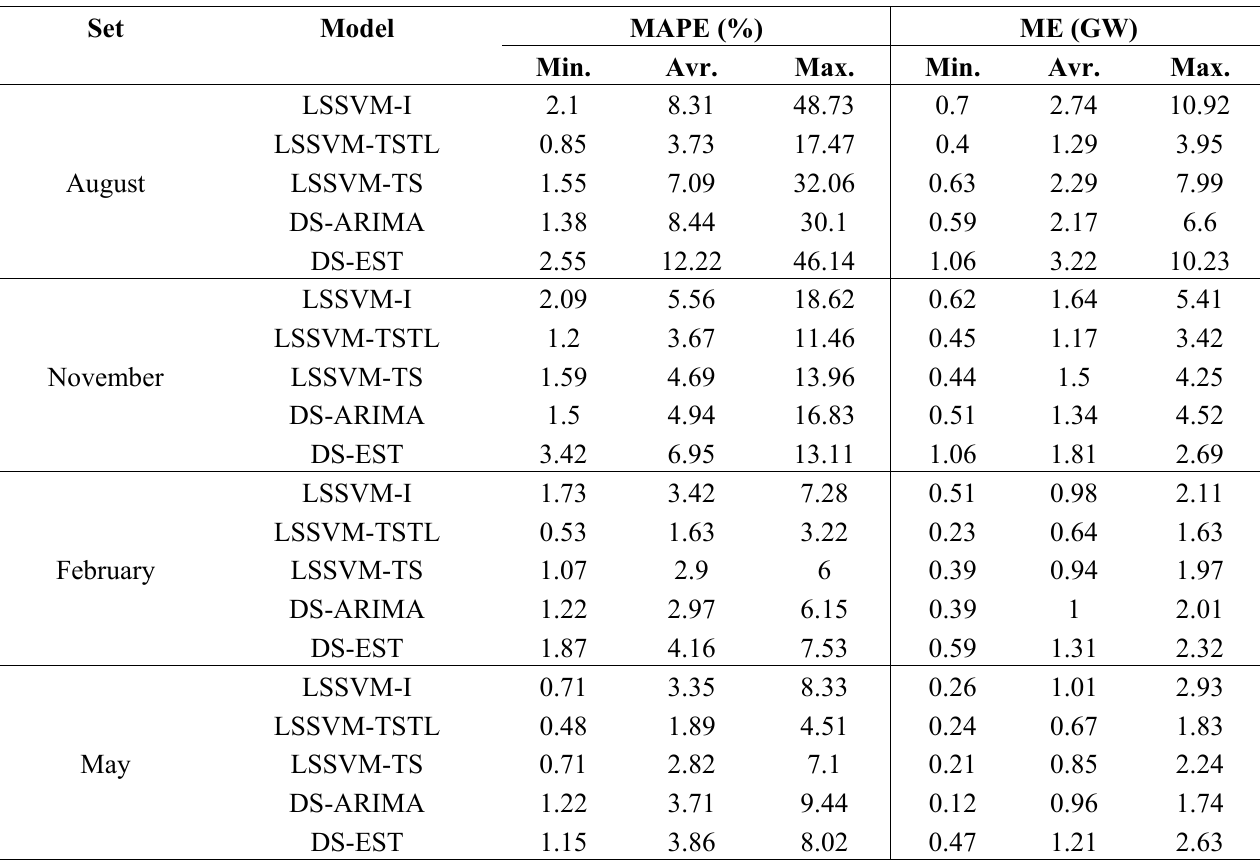
Table 3. Average, max and min daily MAPEs and